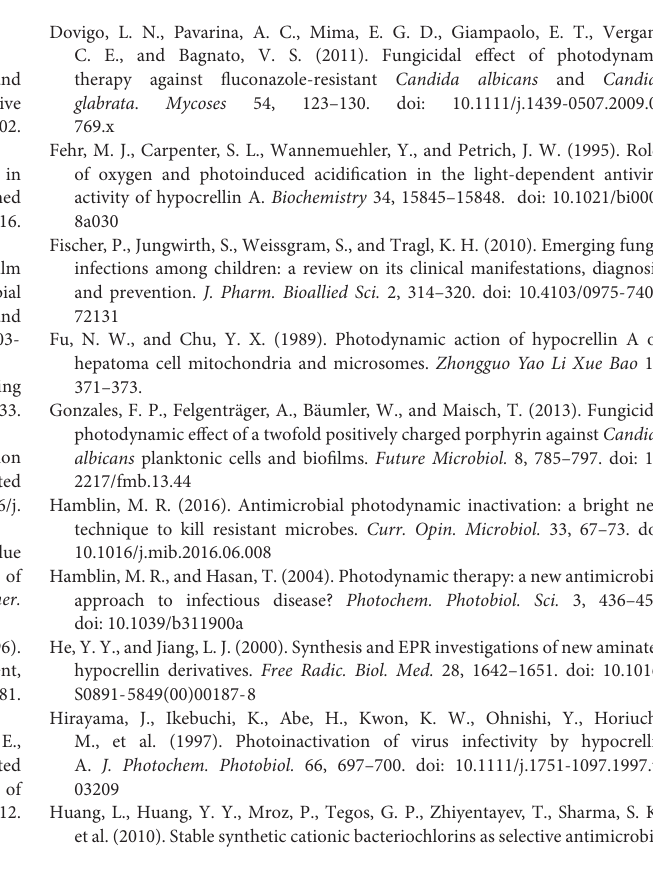
FIGURE S1 | Effect of 1.0 µ g/ml HA on the survival of ATCC18804 and 07318 strains. Data were shown as mean ± SD. ∗ P < 0.05. FIGURE S2 | Effect of 1.0 µ g/ml HA on ROS production of ATCC18804 and 07318 strains. The histogram showed the percentage of DCF-positive cells, and data were presented as mean ± SD. ∗ P < 0.05 and ∗∗∗ P < 0.001. FIGURE S3 | Effect of 1.0 µ g/ml HA on cell membrane potential of ATCC18804 and 07318 strains were assessed using DiBAC4 (3) staining. The histogram was the quantitative analysis of DiBAC4 (3)-positive cells, and data were exhibited as mean ± SD. ∗ P < 0.05 and ∗∗ P < 0.01. FIGURE S4 | Effect of 1.0 µ g/ml HA on cell membrane integrity of ATCC18804 and 07318 strains were assessed using PI staining. The percentage of PI-positive cells was displayed in the histogram, and data were shown mean ± SD. ∗ P < 0.05 and ∗∗ P < 0.01. FIGURE S5 | The mitochondrial transmembrane potential was evaluated using JC-1 staining in ATCC18804 and 07318 strains. The histogram was the quantitative data of fluorescence ratio (Y mean/X mean). ∗ P < 0.05. FIGURE S6 | Metacaspase activity was determined using CaspACE FITC-VAD-FMK in situ marker in ATCC18804 and 07318 strains. The percentage of stained cells was presented in the histogram, and data were presented as mean ± SD. ∗ P < 0.05.